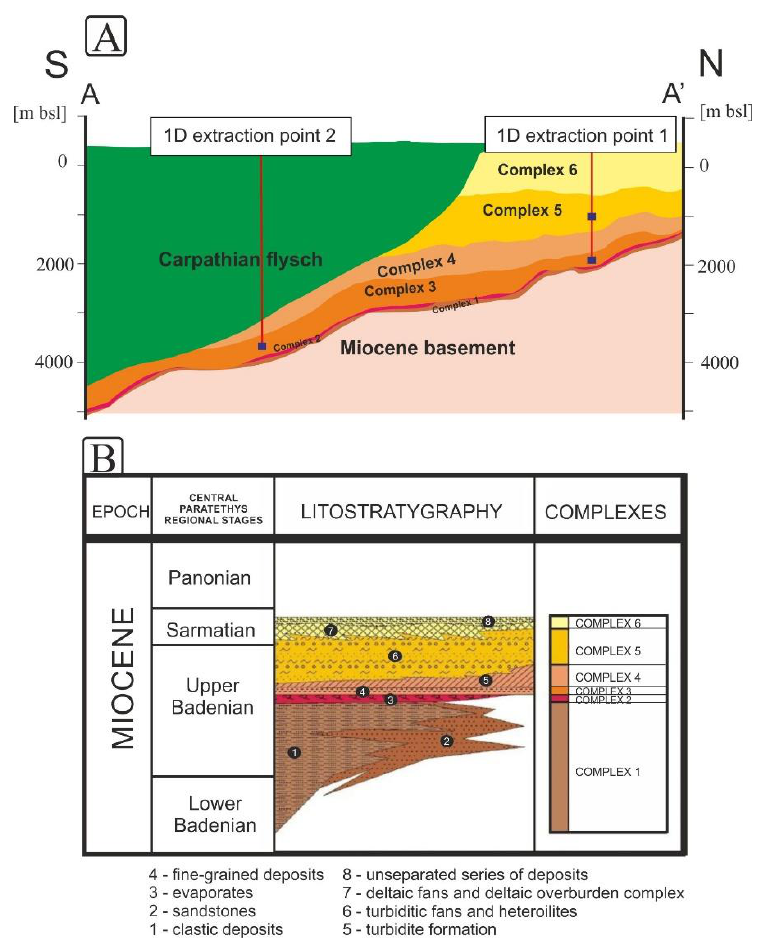
Figure 2. ( A ) Schematic cross-section of study area depicting division of autochthonous Miocene sequence into several major genetic units (location of cross-section line is shown in Figure 1); extraction points with highlighted intervals within Complex 3 and Complex 5 indicate approximate locations for which detailed analysis of the dynamics of generation processes was accomplished (Section 4.2). ( B ) Stratigraphic and lithofacial scheme for Carpathian Foredeep [20]. 3. Model of Miocene Biogenic Gas Generation System: Methodological Approach